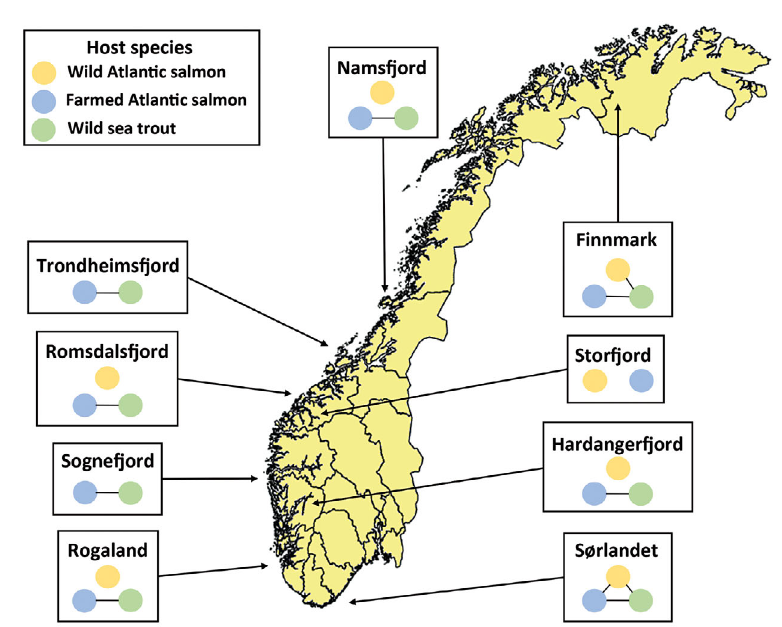
Fig. 4. Frequencies of the pyrethroid resistant genotype compared between host types. In each region, the frequencies of the resistance marker from each host group are compared to the other available host groups. Where there is no signif- icant difference between 2 host groups, they are connected with a line. If there are significant differences, there is no line between the 2 groups. The back- ground map is derived from Global Administrative Areas (2012) and R packages (Becker & Wilks 1993, 1995, Pebesma & Bivand 2005, Bivand et al.